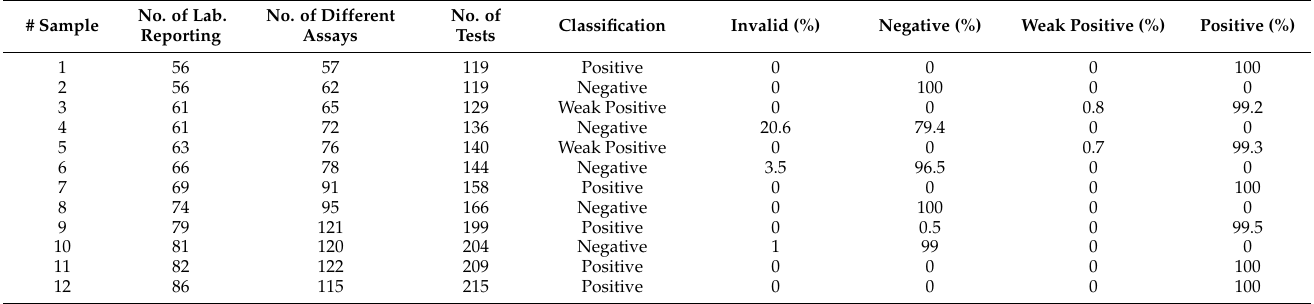
Table 1. Number of laboratories (lab.) reporting, number of assays, number of reported testing and results of the SARS-CoV-2 nucleic acid detection